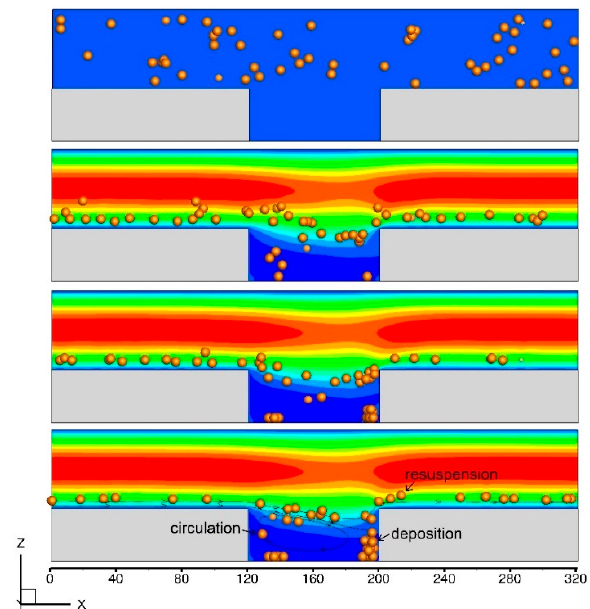
Figure 25. Snapshots of the particle suspensions for Re = 56.88, h = 32, l = 80 and ρ p = 1.5. The time point for each subplot is t = 0, t = 50,000, t = 200,000 and t = 500,000 from top to bottom, respectively. The flow field only contains a slice at the mid-plane in y direction. Some particles may be sheltered and look smaller.